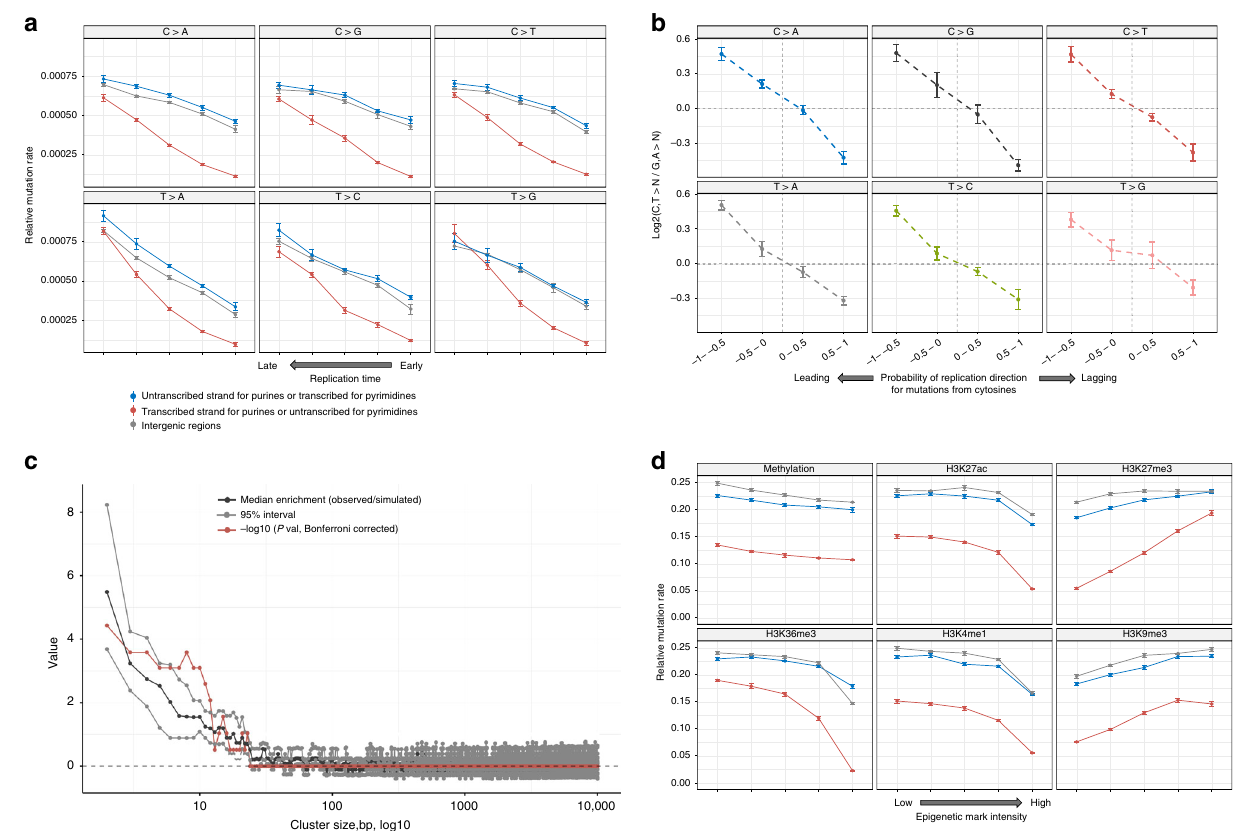
Fig. 4 Genomic landscape of mutagenesis in XP-C internal tumors. a Mutational density on the transcribed, untranscribed DNA strands of genes as well in intergenic regions presented as a function of replication timing in XP-C leukemia ( n = 6, SEMs are indicated). Replication time is split onto fi ve quantiles. Mutation rate for pyrimidines on the transcribed strand (or purines on the untranscribed, blue) is not different from intergenic regions within the same bin, which is compatible with the absence of GG-NER. b Pyrimidine/purine ratios of mutation rates for regions of the genome grouped by propensity of reference DNA strand to be replicated as leading (left) or lagging (right) strand during DNA synthesis for XP-C leukemia genomes ( n = 6, SEMs are indicated). Strong enrichment of mutagenesis on the leading strand from pyrimidines (C and T) (lagging strands from purines (G and A)) is observed for all six classes of mutations. Mutations from purines on the lagging DNA strand may result from error-prone Translesion Synthesis. c The assessment of the length of clustered mutation events on the distances ranging between 2 and 10,000bp. Sliding window of 5 bp was used to estimate median effect size (black) and its 95% con fi dence interval (gray) as well as Bonferroni-corrected − log10 ( P value) (red, Wilcoxon signed-rank test, two-sided) for different length of clusters in real data (XP-C leukemia, n = 6) against simulations (see “ Methods ” section). The highest and signi fi cant enrichment of clustered mutations was observed for short clusters with lengths between 2 and 16 bp. d Intensity of epigenetic marks (5 quantiles) and relative mutation load for XP-C leukemia ( n = 6, SEMs are indicated). Mutational density on the transcribed, untranscribed DNA strands of genes as well in intergenic regions positively correlated with repressive histone marks H3K27me3 and H3K9me3, and inversely correlated with active chromatin marks (H3K27ac, H3K36me3, H3K4me1). For all three genomic categories, effect of the majority of epigenetic marks was similar. At the same time correlations of untranscribed strand for pyrimidines (or transcribed for purines, red) with H3K27me3 and H34M36me3 were more important than for the other two